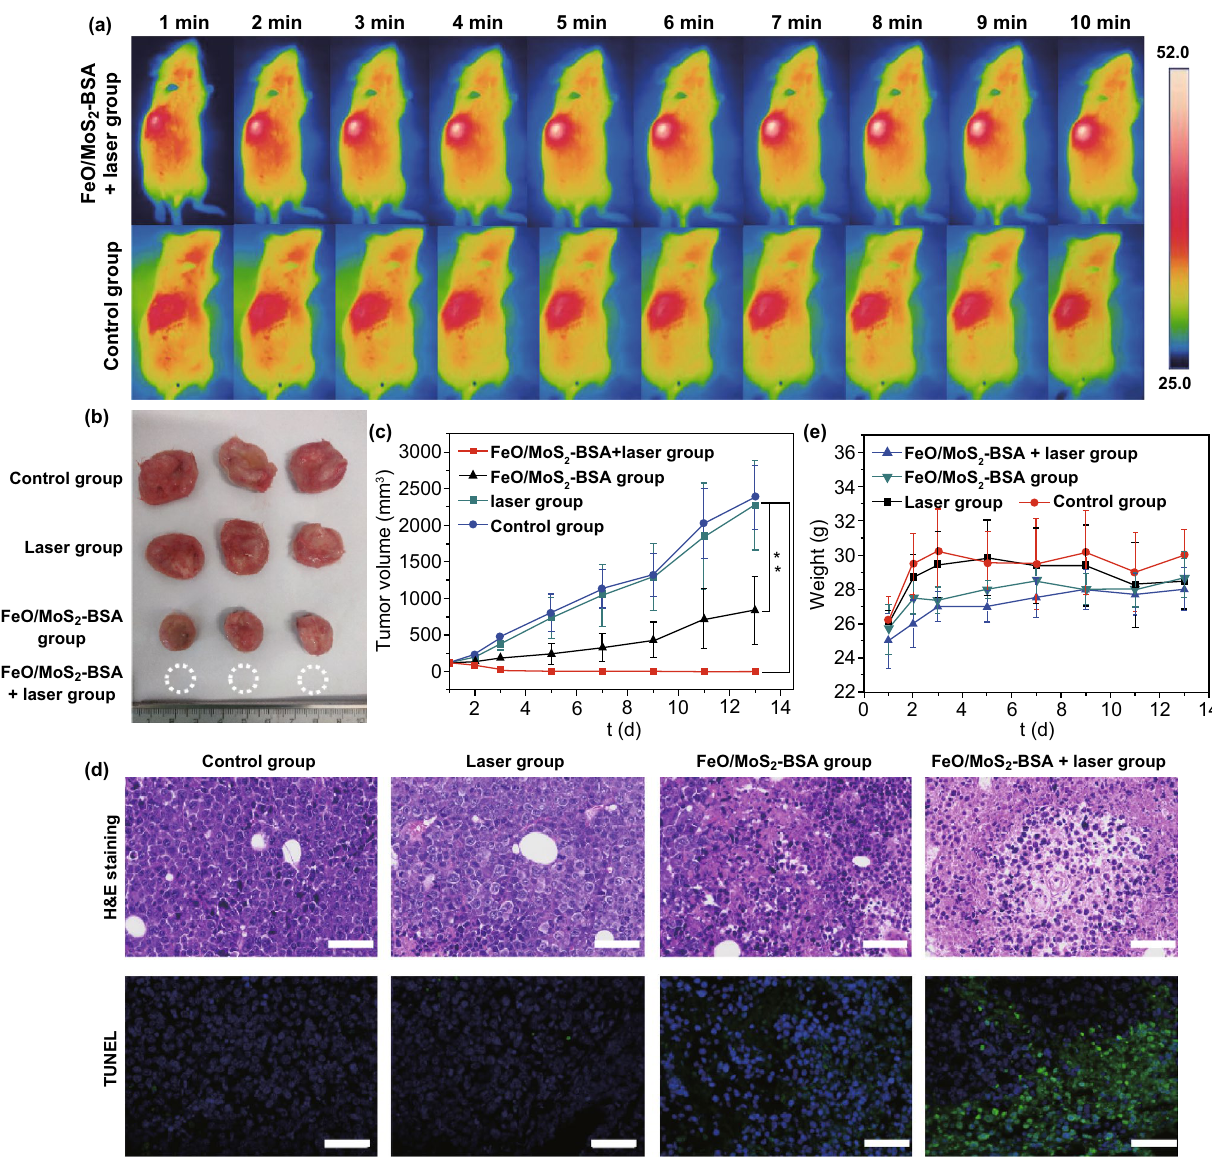
Fig. 4 a IR thermal images of Kunming tumor -bearing mice with tail vein injection of normal saline and FeO/MoS 2 -BSA nanocompos- ites (200 µL, 400 µg mL −1 ) under 1064 nm laser irradiation (0.75 W cm −2 ) in every minute for 10 min. b Tumor photos harvested from the mices after various treatment at 14th day. c Tumor volume growth on mice measured after different treatments every 2 days for 2 weeks ( n = 6, ** P < 0.01). d H&E and TUNEL staining of tumor sections harvested from the mice after different treatments at third day (scale bars: 50 μm). e Tumor weight growth on mice measured after different treatments every 2 days within 2